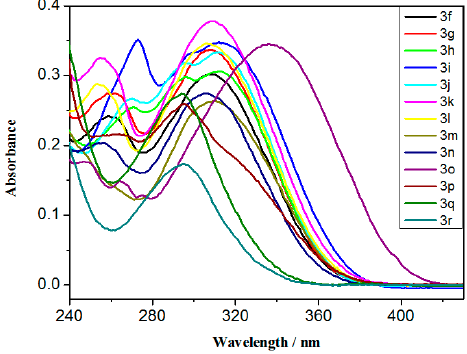
Figure 4. The absorption spectra of compounds 3 ( f – r ).